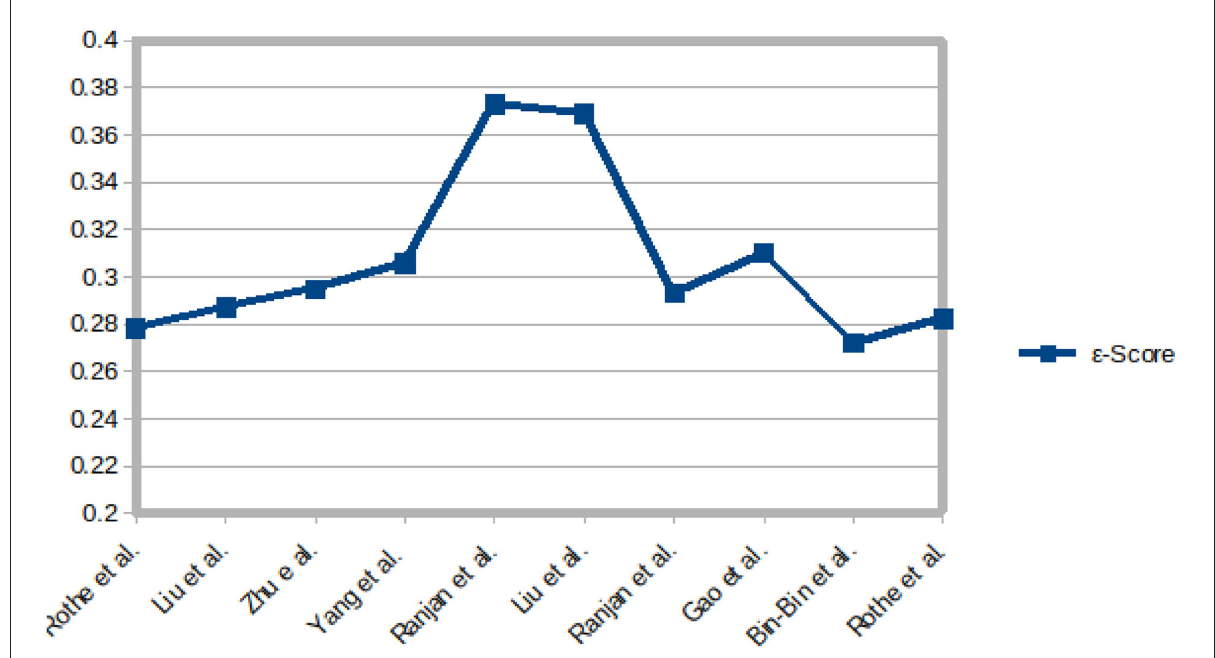
FIGURE5 Performance, in terms of ǫ -error, achieved by some authors on the Chalearn LAP-2015 dataset.